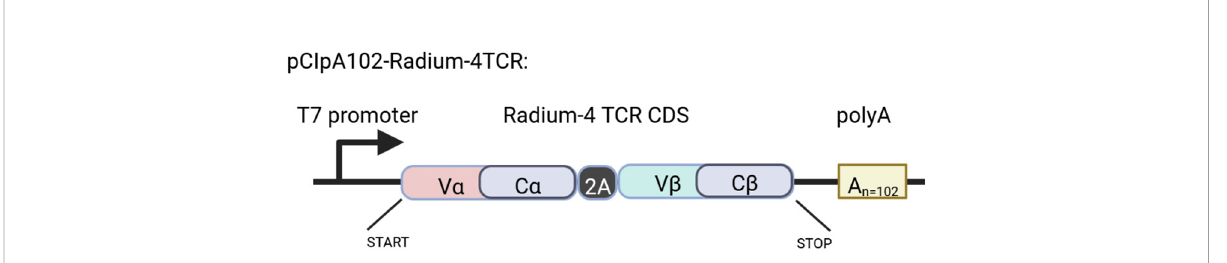
FIGURE 5 Schematic representation of the Rad4 TCR construct in the pCIpA102 expression vector used for the in vitro transcription of Radium-4 TCR mRNA. Created using